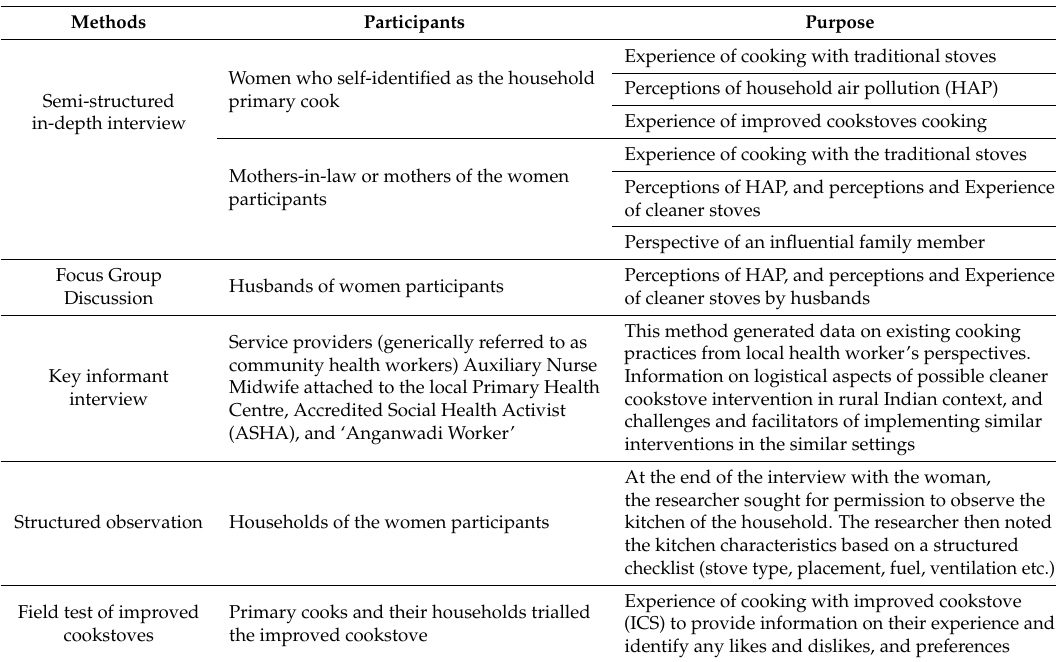
Table 1. Data collection methods, participants and